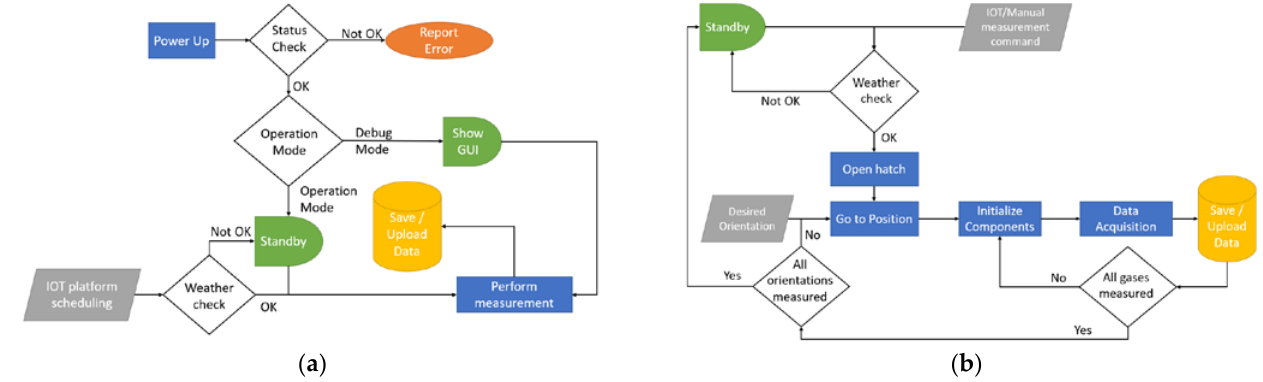
Figure 5. Flowcharts ( a ) for the device operation ( b ) for the measurement procedure.